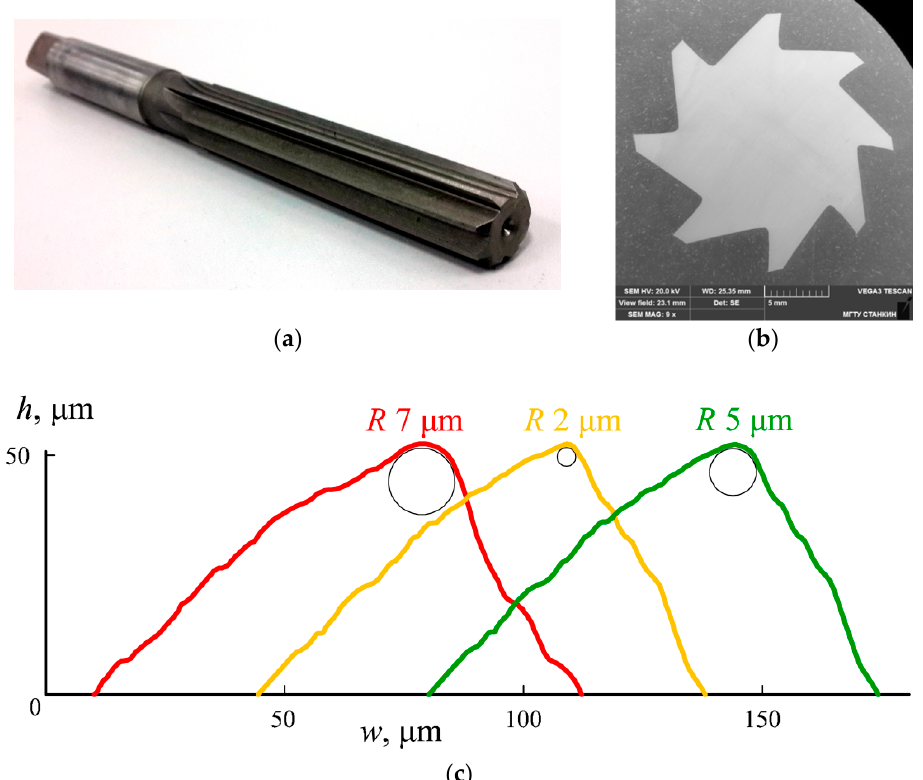
Figure 5. A 16-mm-diameter reamer made of high-speed steel HS6-5-2: ( a ) a photograph of the reamer; ( b ) scanning electron microscope (SEM) image (9×) of reamer cross-section; ( c ) profiles of the ( b ) scanning electron microscope (SEM) image (9 × ) of reamer cross-section; ( c ) profiles of the reamer cutting edges before processing (on the left), after sharpening and nitriding (in the middle) and after synthesis on the nitrided surface of the 3 µ m thick TiN coating (on the